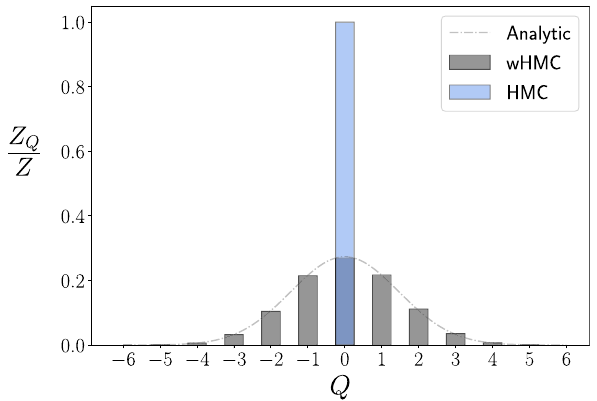
Fig. 11 Z Q / Z versus Q at β = 11 . 25 for HMC and wHMC, versus the analytical result